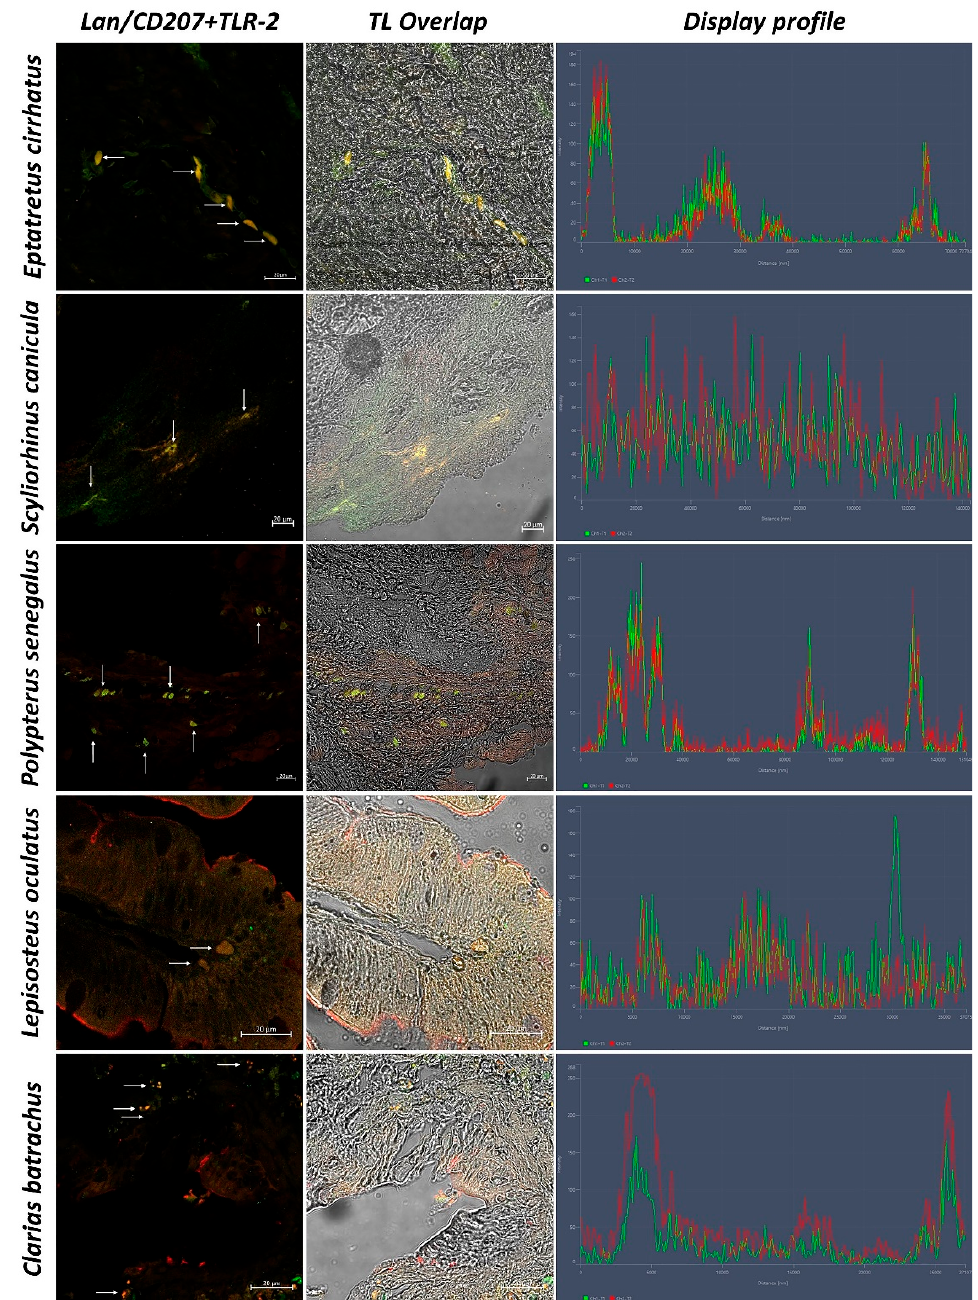
Figure 7. Colocalization of Langerin/CD207 and TLR-2, 40x, scale bar 20 µm. The colocalization of Langerin (green) and TLR-2 (red) is evident (arrows). Overlap in Transmitted Light (TL) is used to compare the organ morphology. The “display profile” function was used to confirm the antibodies colocalization.